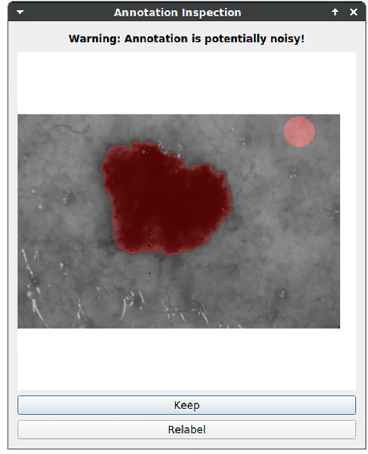
Figure 10: Illustration of methods in annotation inspection. Exemplary results of using the number of segments as an annotation quality criterion. Assuming only one melanoma per image, a warning is shown because two segments are marked.